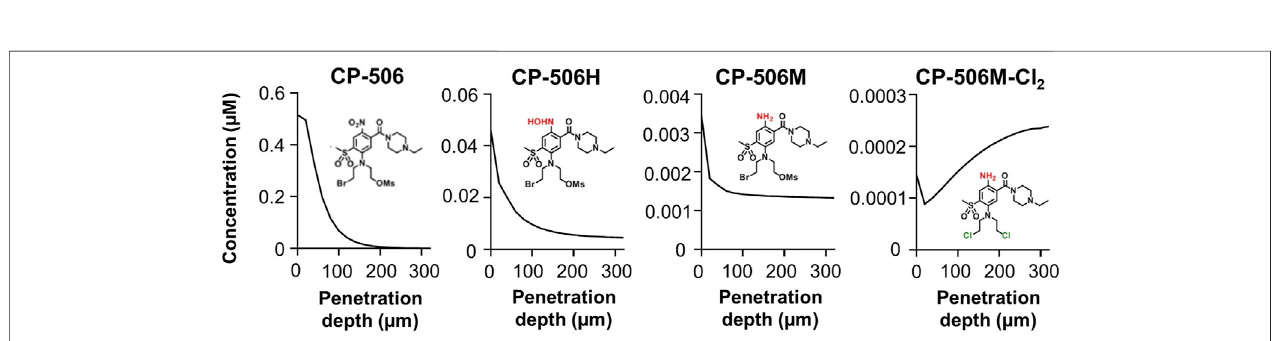
FIGURE 8 | ABM simulations of the intracellular concentration gradients of CP-506 and its reduced metabolites in a transverse section of a multicellular spheroid.